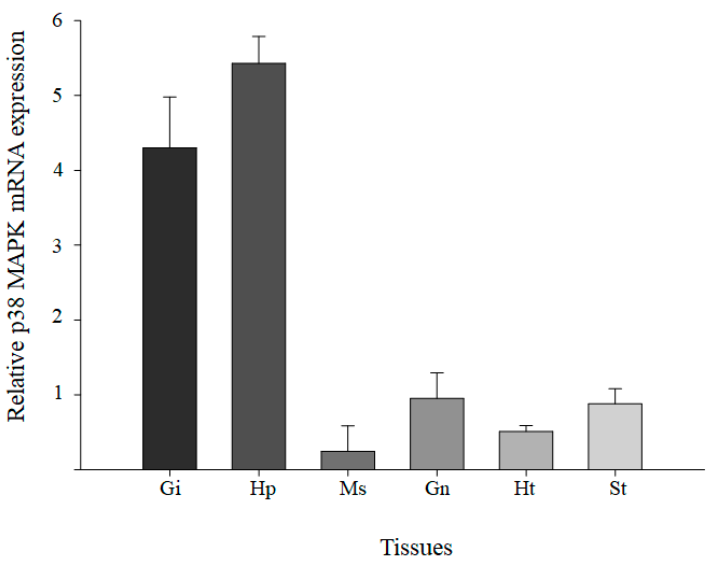
Figure 3. The distribution of M. japonicus p38 MAPK transcripts in different tissues (Gi, gill; Hp, hepatopancreas; Ms, muscle; Gn, gonad; Ht, heart; St, stomach). Each tissue was collected from 10 mud crabs. The experiments were performed in triplicate. The relative expression levels of each gene in each tissue were normalized by GAPDH transcript and data were presented as the mean ± SD.